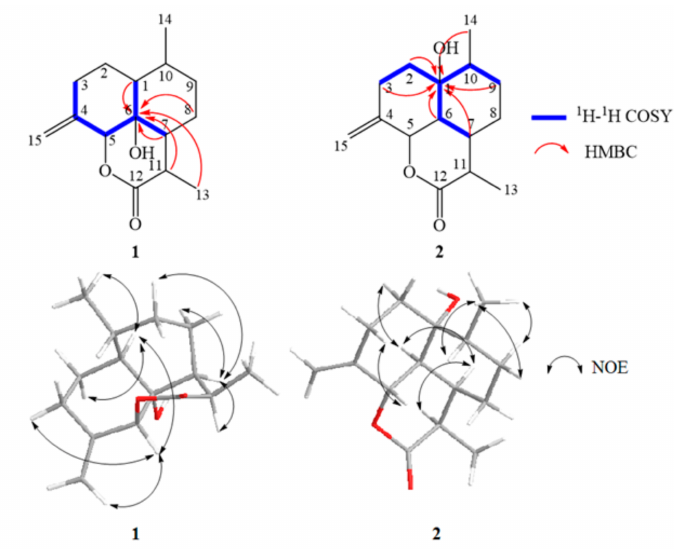
Figure 5. Key COSY, HMBC and NOE correlations of compounds 1 and 2